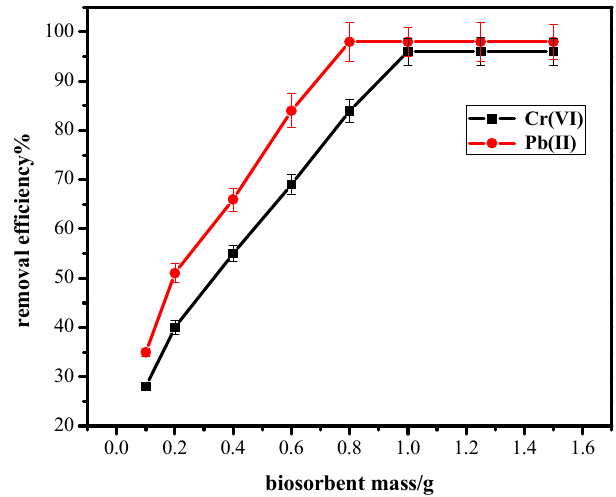
Figure 2. E ff ect of biosorbent mass on the removal e ffi ciency of Pb(II) and Cr(VI) from aqueous solutions Figure 2. Effect of biosorbent mass on the removal efficiency of Pb(II) and Cr(VI) from aqueous (metal ion concentrations: 50 mg / L for Pb(II) at pH 4.6 and 70 mg / L pH 4 for and Cr(VI); temperature: solutions (metal ion concentrations: 50 mg/L for Pb(II) at pH 4.6 and 70 mg/L pH 4 for and Cr(VI); 25 ◦ temperature: 25 °C).